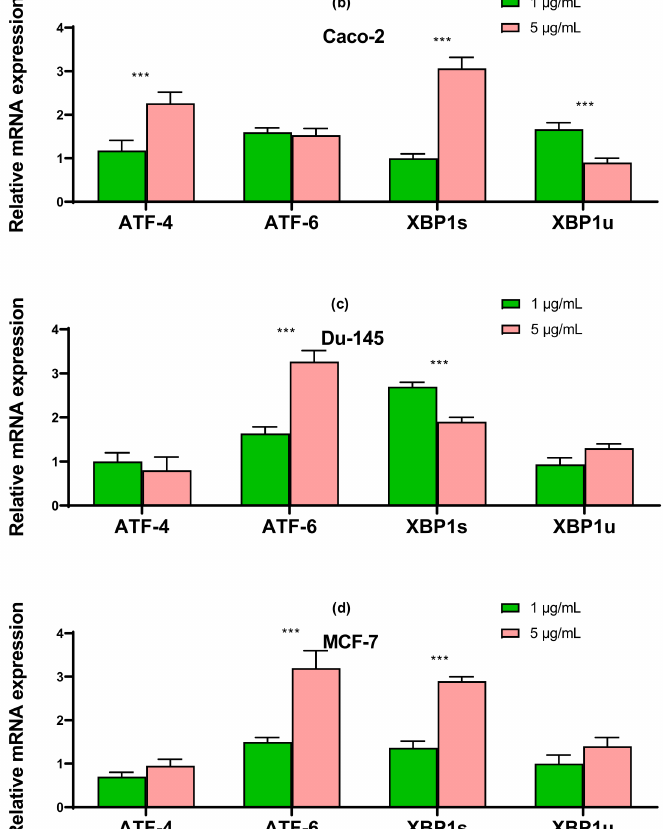
Figure 5. qRT PCR analysis of the expression of ER stress response in gene (1 and 5 µ g/mL SeNP, 24 h)-treated cancer cells ( a )—A-172; ( b )—Caco-2; ( c )—Du-145; ( d )—MCF-7. Each value is the mean ± SD of at least three independent experiments ( n ≥ 3, p < 0.05). GAPDH was used as an internal control for normalization. Two-way ANOVA with Sidak’s multiple comparisons test.